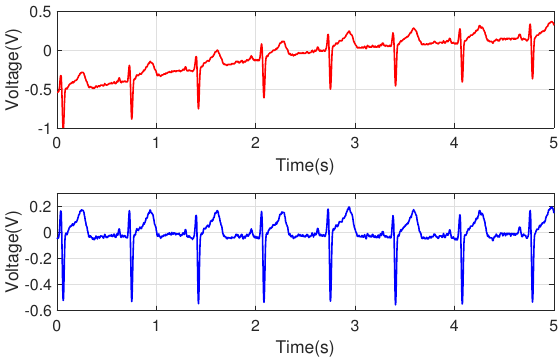
Figure 3. Example of ECG signals after a band-pass filter was applied: ( top ) raw ECG signal; ( bottom ) signal after filtering is applied (note that the increasing transition of baseline is removed).